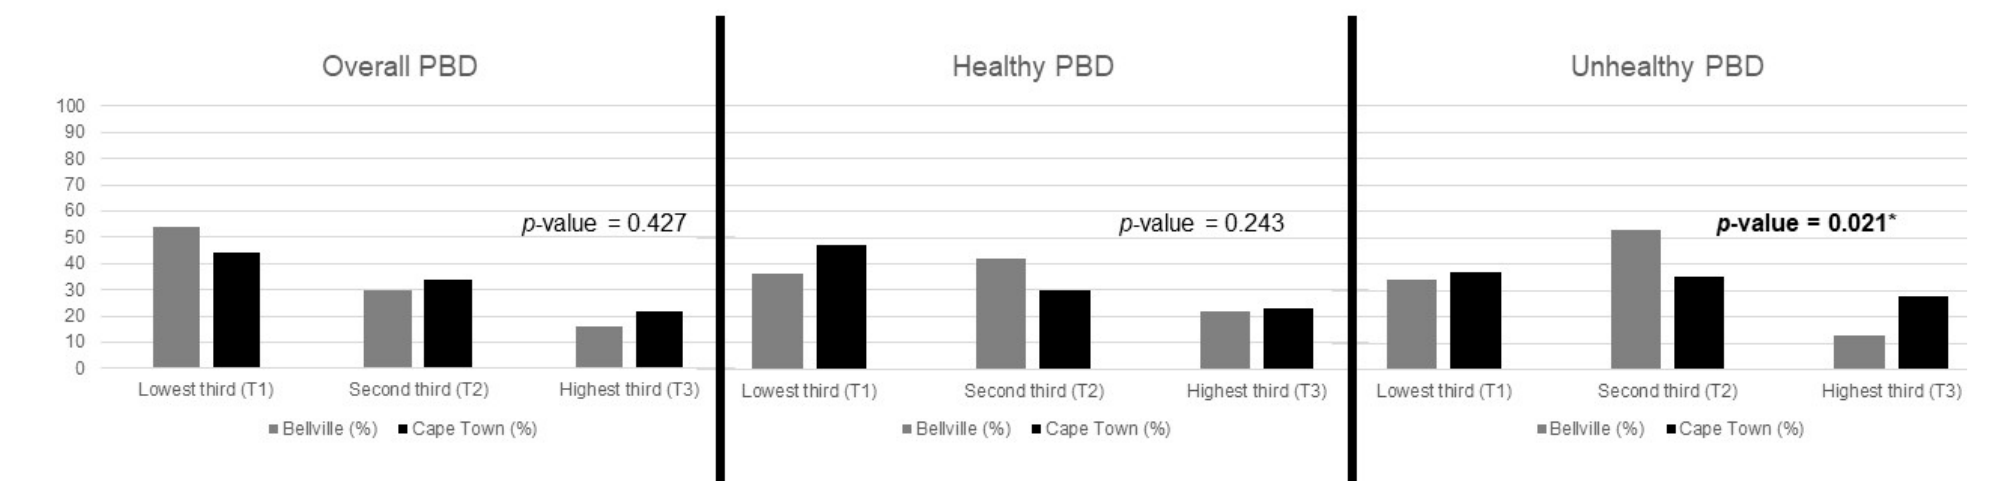
Figure 2. Prevalence of PBDs according to study area. Statistically significant p -values less than 0.05 are indicated in bold with an asterisk.